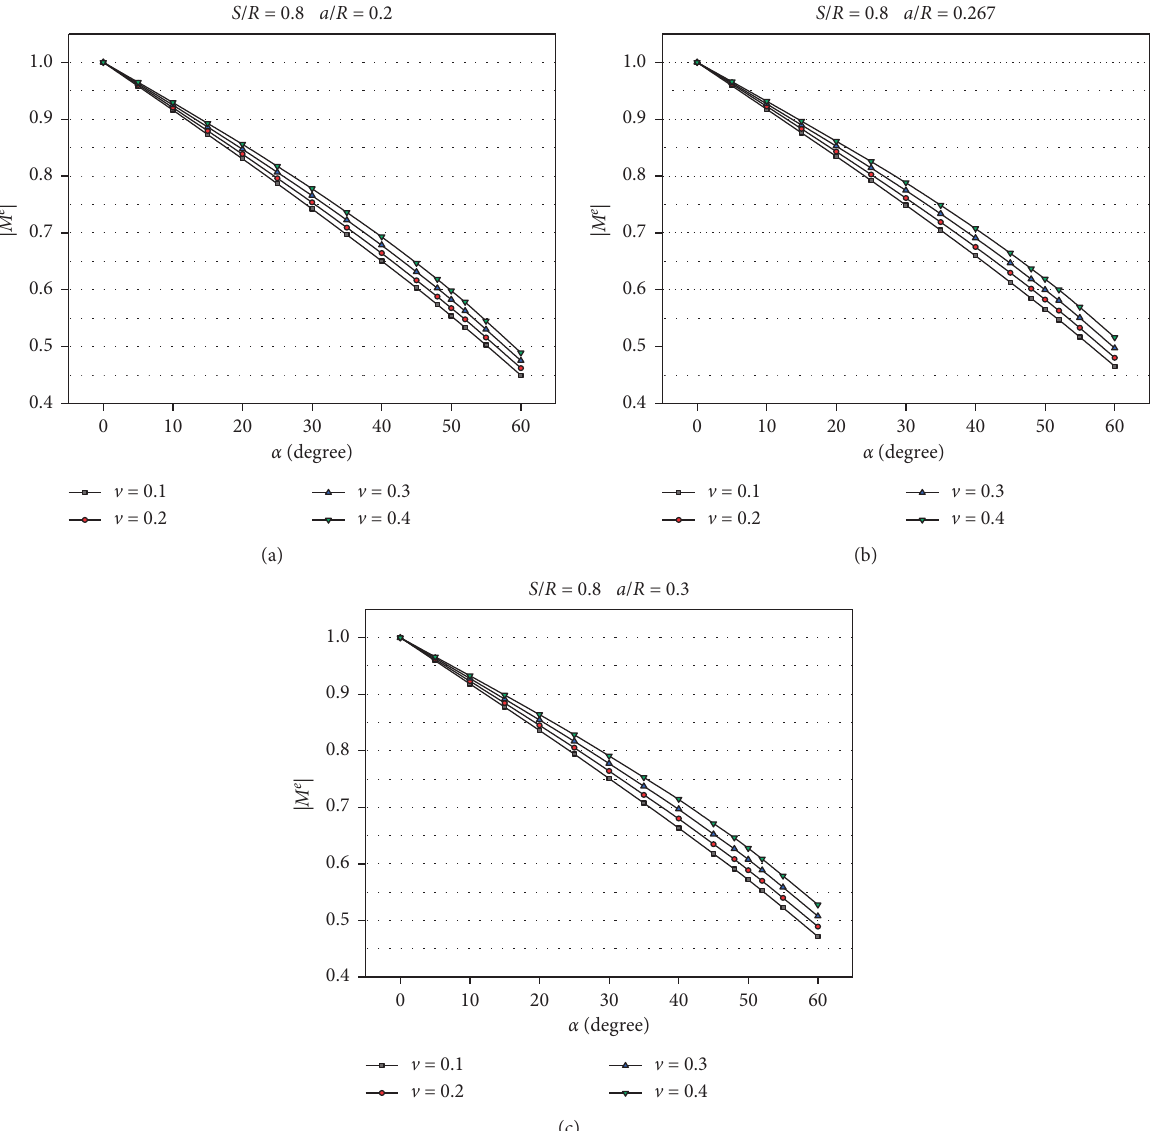
Figure 8: Variations of | M e | with α for different values of a / R and v in the SCB